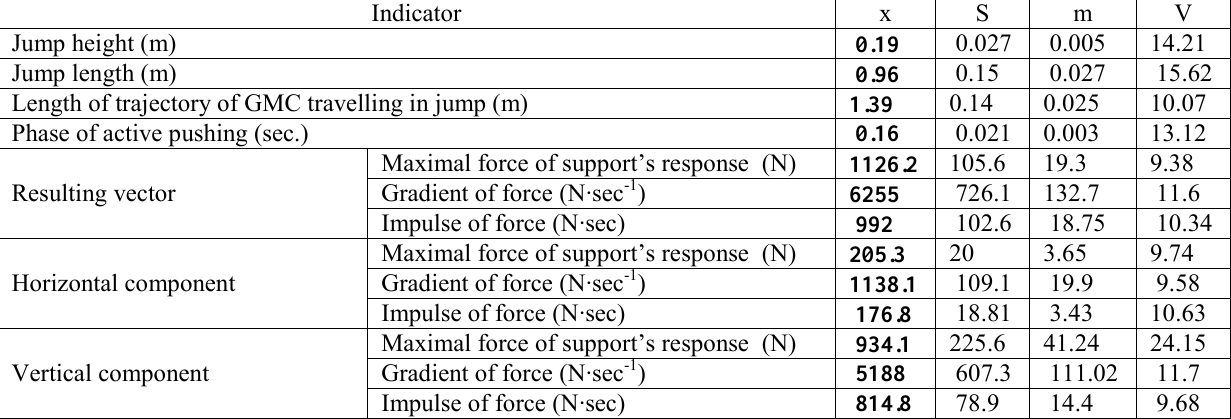
Indicators of test “running high-forward jump, pushing with one leg”